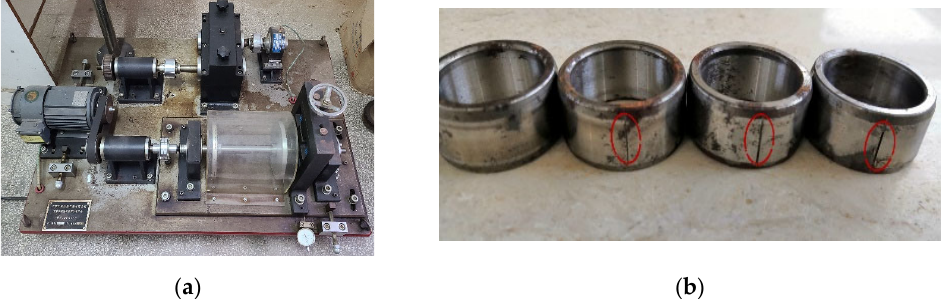
Figure 4. experimental platform: ( a ) The test bench; ( b ) Photographs of defective components under study.